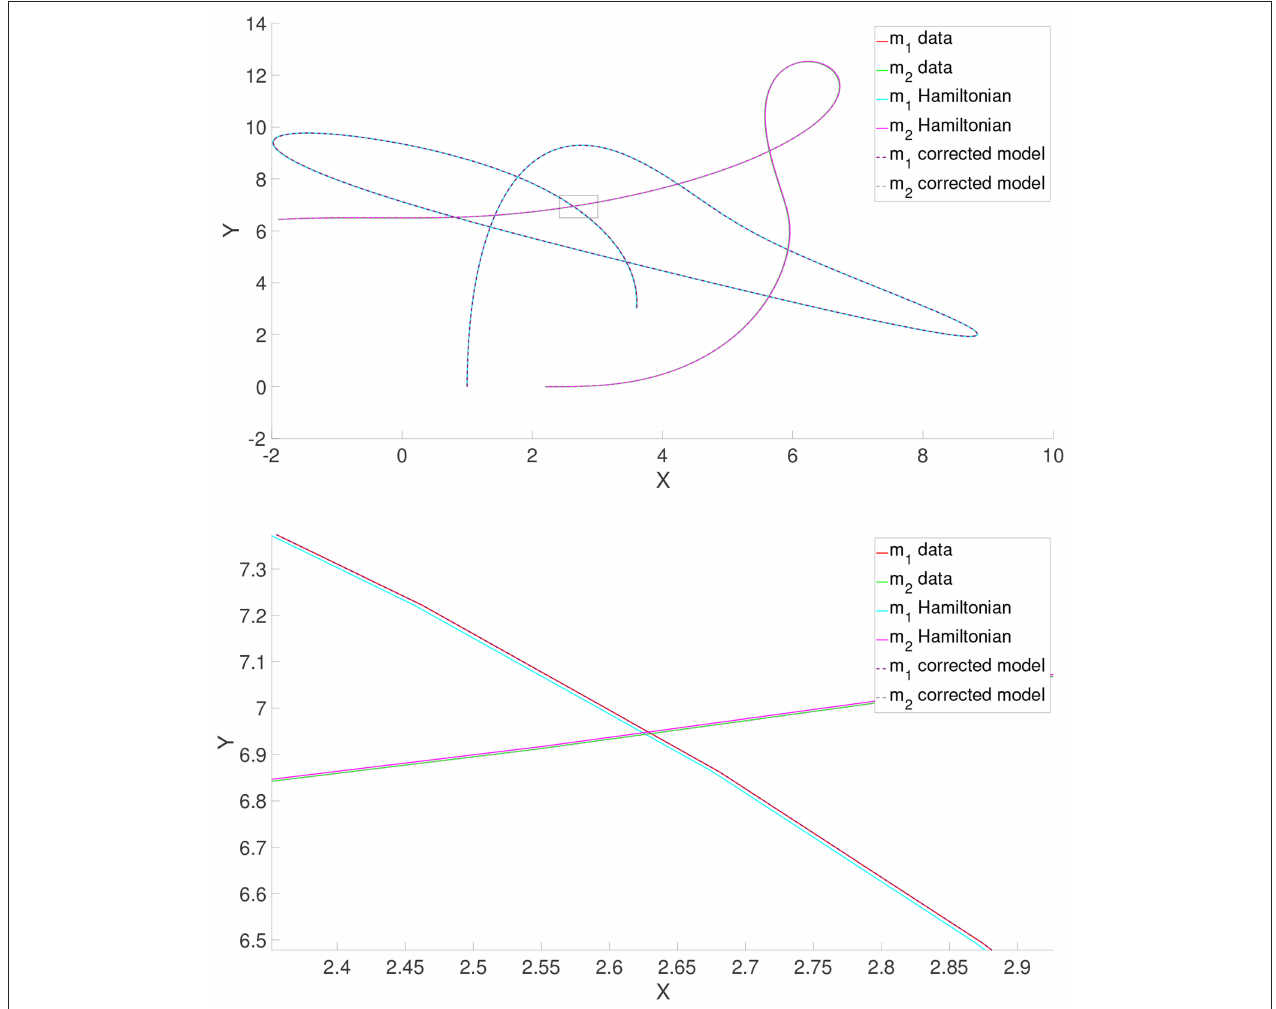
FIGURE 2 | Results for the thermal pendulum problem. Results are shown (see the detail in the small window in the bottom figure) for the ground truth (pseudo-experimental data), the uncorrected (purely Hamiltonian) assumed model and the corrected